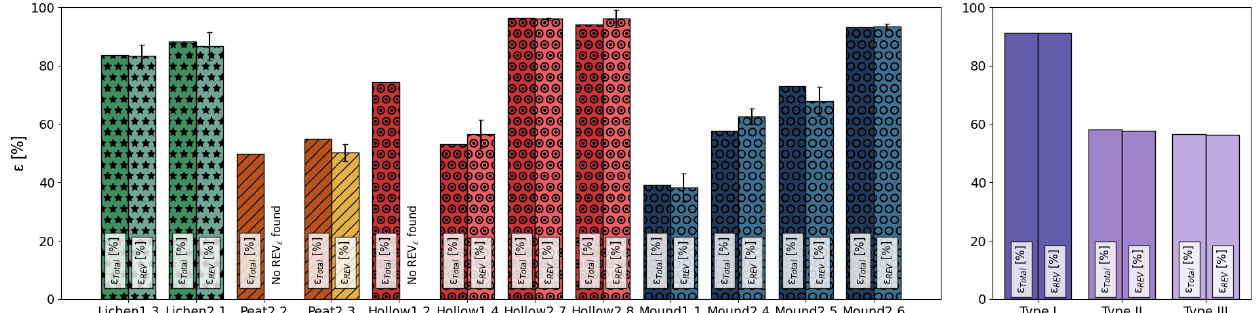
Figure 7. Numerical porosity estimations (%) for each sample. An averaged value is computed for each identified sample type (I, II, III) with corresponding color nuances. Peat 2.2 and Hollow1.2 did not admit any REV.